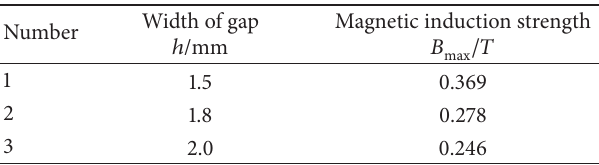
Table 4: Simulated results of magnetic induction strength for different width of gap.